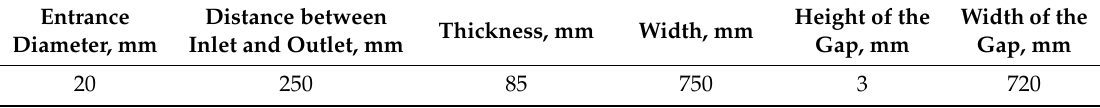
Table 1. The quantitative parameters of the coat-hanger die.